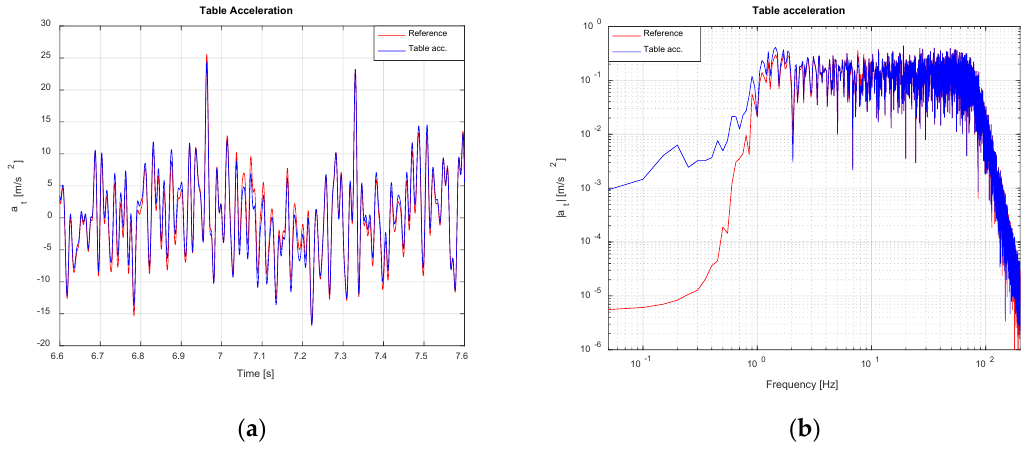
Figure 17. Shake table acceleration tracking (noise-free scenario). TVC disabled: ( a ) Time domain; ( b ) Frequency domain.